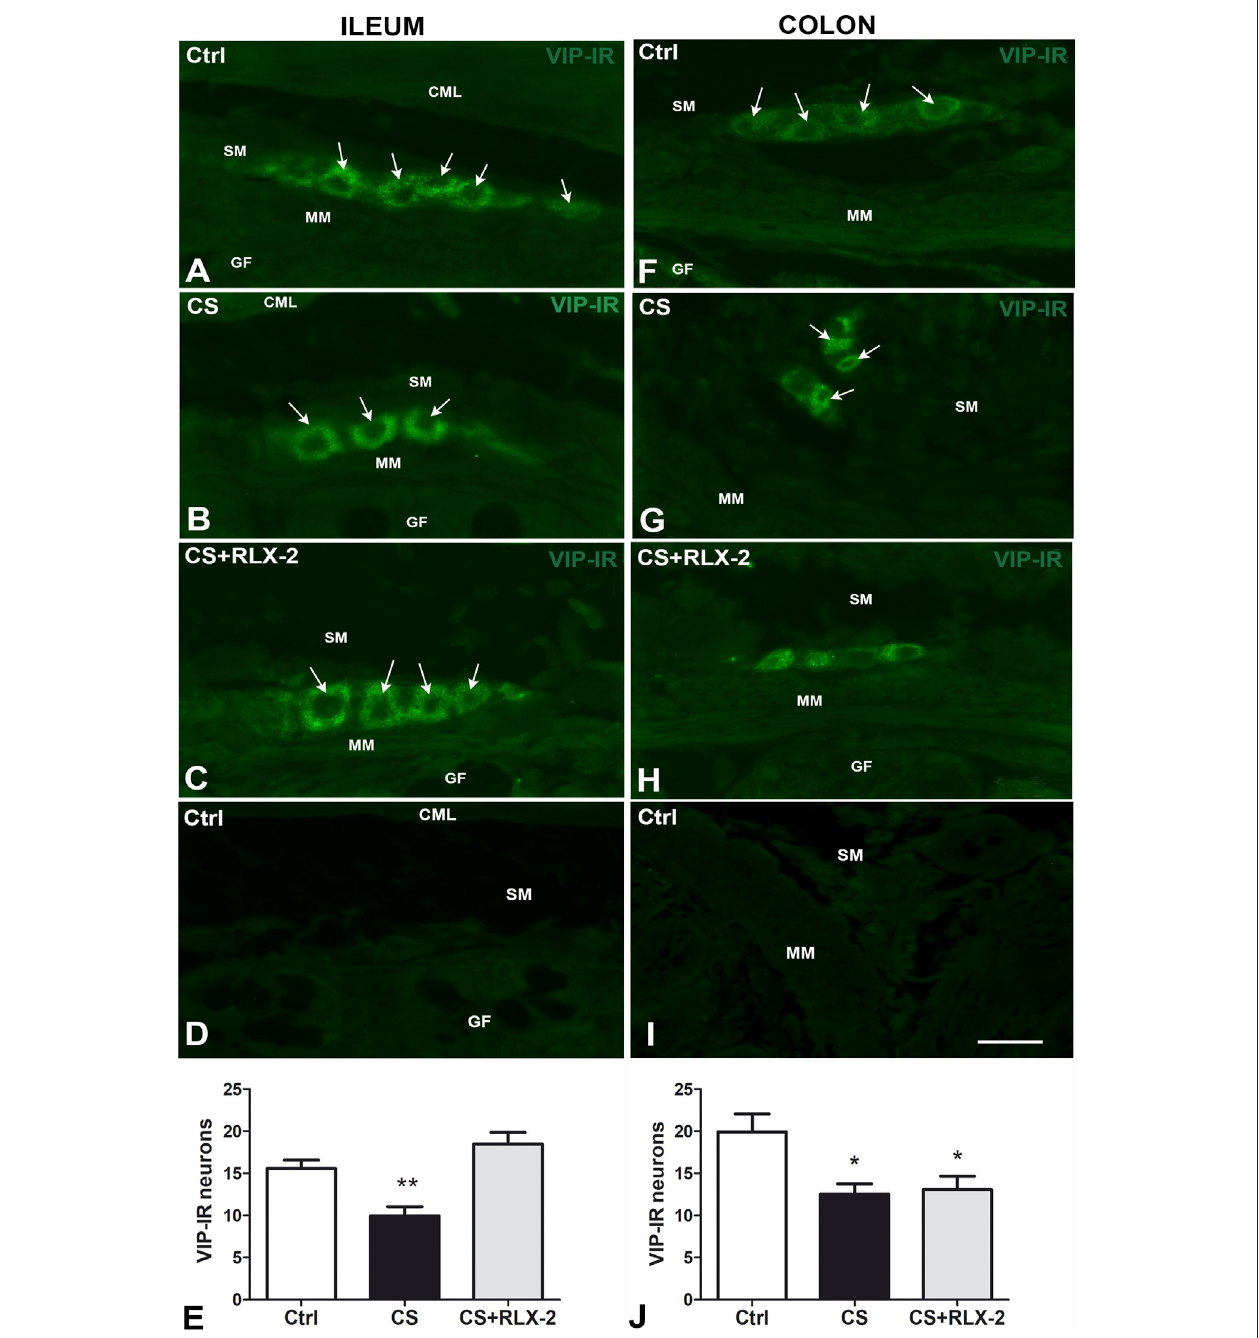
FIGURE 5 | A – I Vasoactive intestinal peptide (VIP)-immunoreactive (IR) submucosal neurons in the ileum (A – D) and colon (F – I) of the cigarette smoke (CS) group and effects of relaxin-2 (RLX-2). Full-thickness sections. In both regions and in all groups of animals, labeling was detected only inside the ganglia. IR had a granular aspect and was located in the somata and in the fi rst tracts of the processes. (E) In the ileum, the number of VIP-IR neurons was signi fi cantly decreased in CS-exposed animals, and RLX-2 administration prevented this decrease. (D,I) : negative controls. (J) In the colon, the number of VIP-IR neurons was signi fi cantly decreased in CS-exposed animals, but RLX-2 did not prevent this decrease. CML , circular muscle layer; SM , submucosa; MM , muscularis mucosae; GF , glandular fundus. Bar , 25 μ m (A – D; F – I) . * p < 0.05; ** p < 0.005.